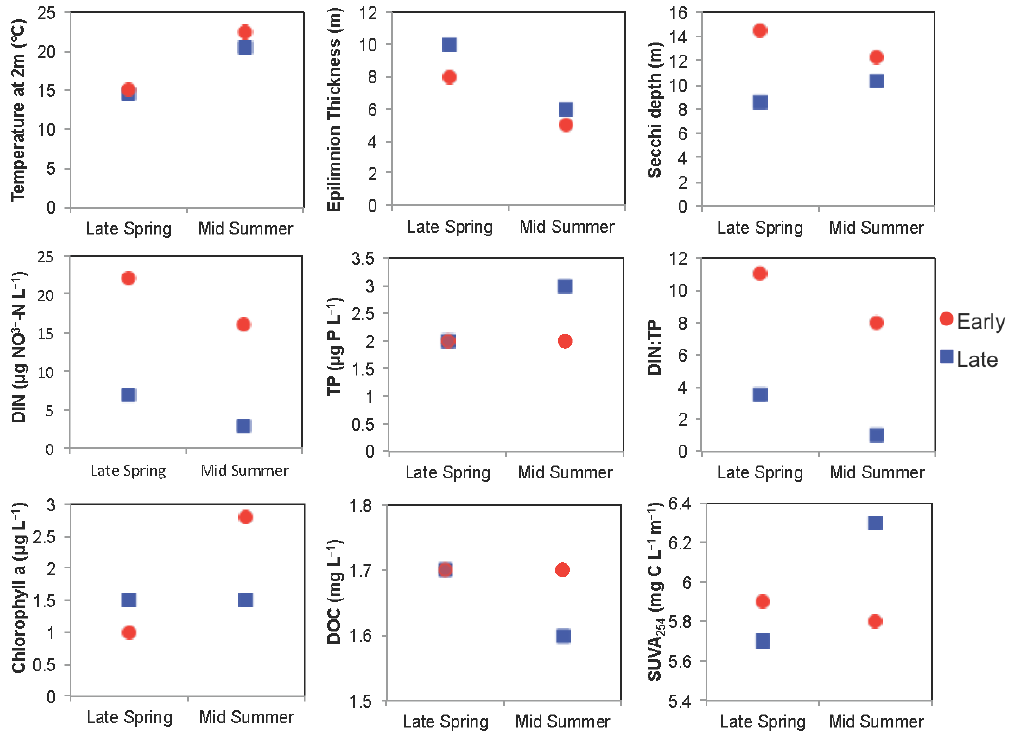
Figure 7. Comparison of lake metrics for early and late ice-out conditions during the spring and summer in the boreal lake. Responses represent one sampling for each of the time periods. For the 2012 early ice-out year, spring sampling occurred on 11 June and summer sampling was conducted on 12 July. For the 2015 late ice-out year, spring sampling occurred on 11 June and summer sampling was conducted on 10 July. Purple points indicate overlapping results for early and late ice-out years.